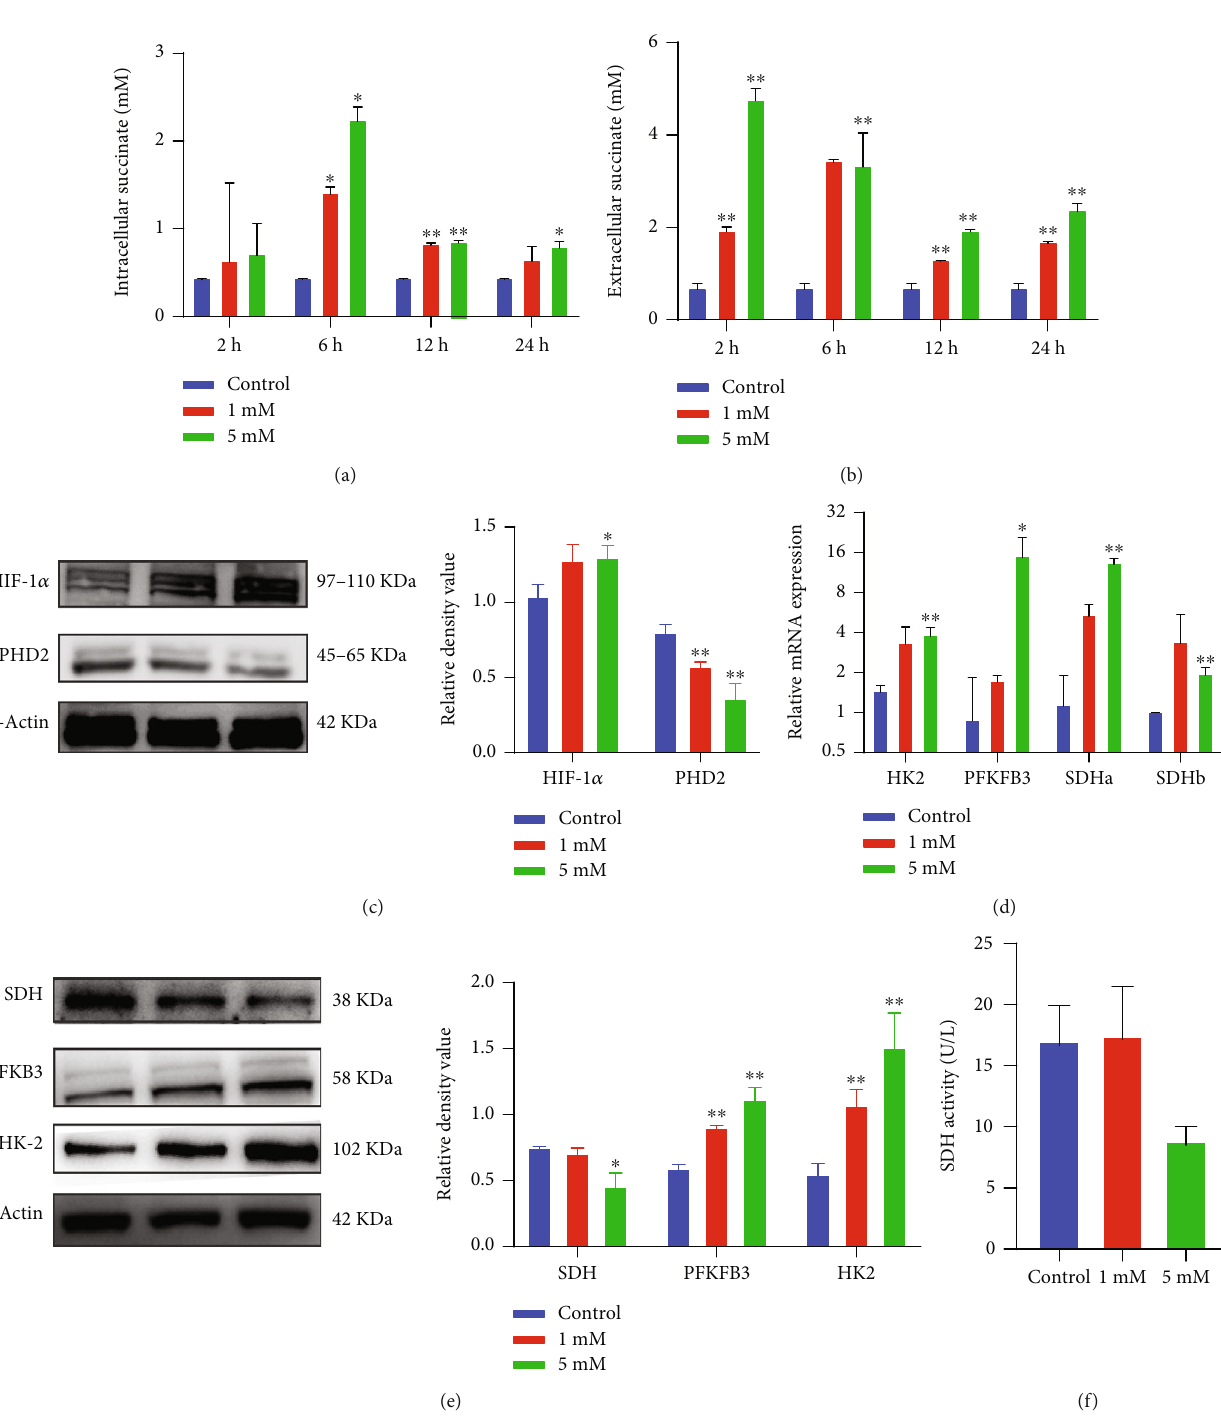
Figure 4: Succinate supplement elicited intracellular succinate accumulation, pseudohypoxia condition, and glycolysis. The intracellular succinate in cell lysates and extracellular succinate in supernatants were assessed ( n = 3 ) (a, b). Changes in PHD2 and HIF-1 α at 2 h after succinate treatment were measured by western blot (c). The mRNA and protein of genes involved in the OxPhos and glycolysis were analyzed at 4 h by qPCR and at 24 h by western blot, respectively (d, e). SDH activity was measured by ELISA after 6h stimulation ( n = 3 ) (f). Blots were representative of 3 independent tests. ∗ p < 0 : 05 , relative to control; ∗∗ p < 0 : 01 relative to